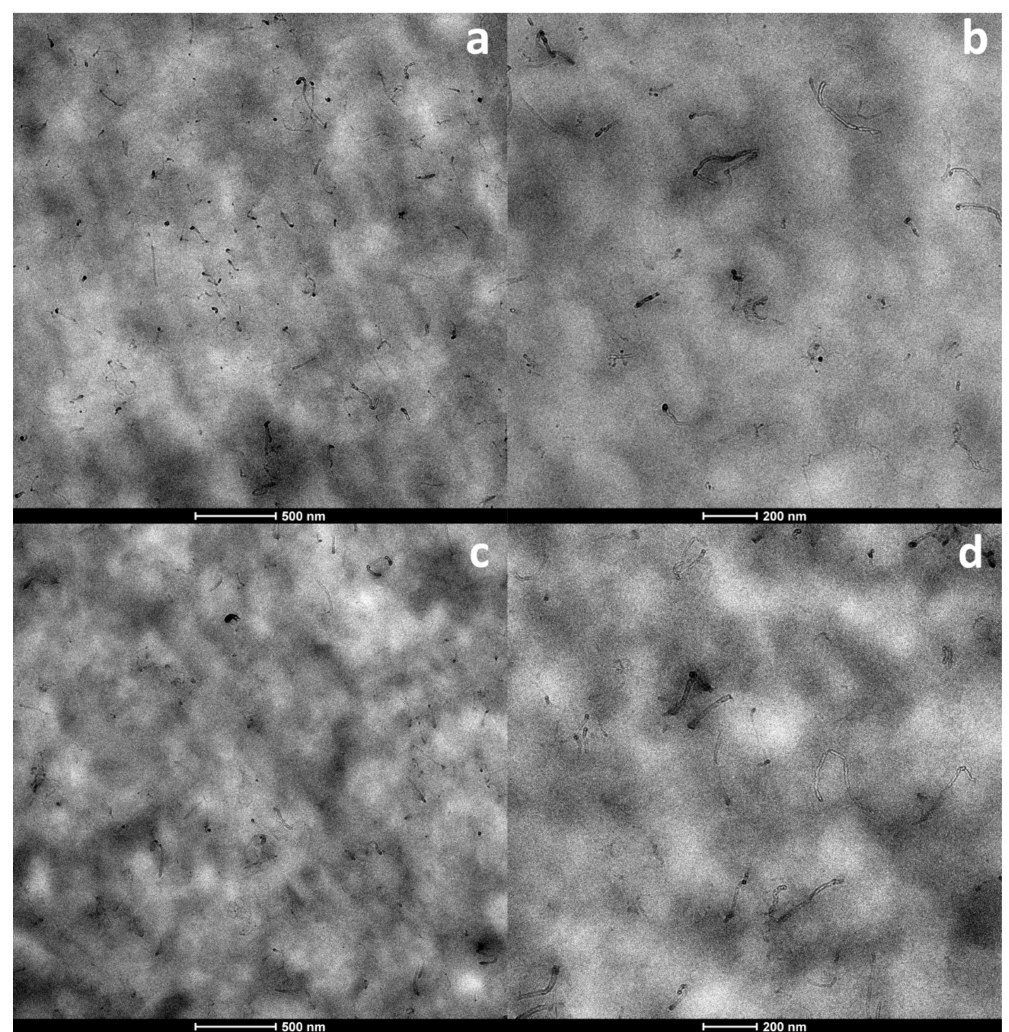
Figure 5. TEM micrographs of PA410/Pebax/CNT ternary ( a , b ) and PA410/PA6/Pebax/CNT quaternary ( c , d ) NCs with a CNT content of 0.4 wt%, at × 14,500 and × 25,000